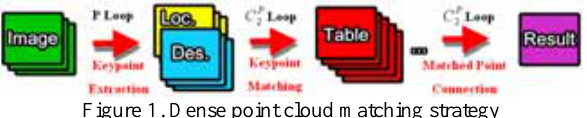
Figure 1. Dense point cloud matching strategy